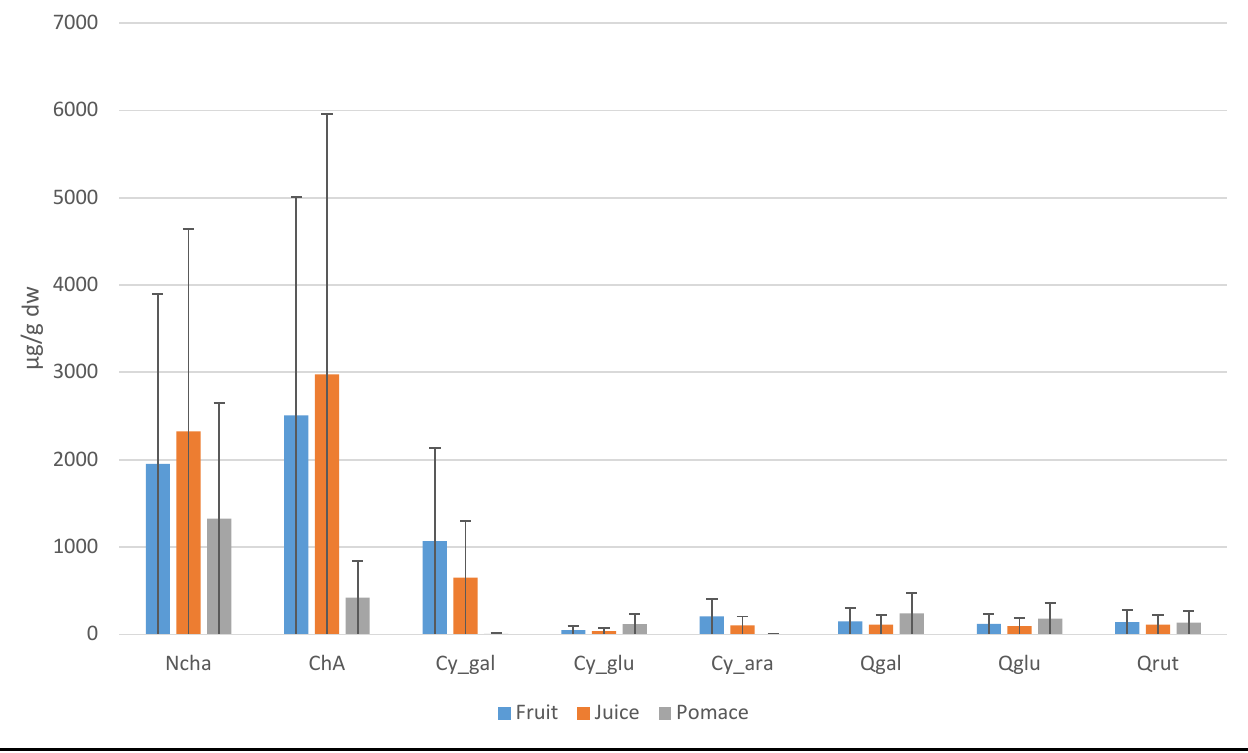
Figure 3. The mean contents of major polyphenolic compounds for all cultivars in current study.